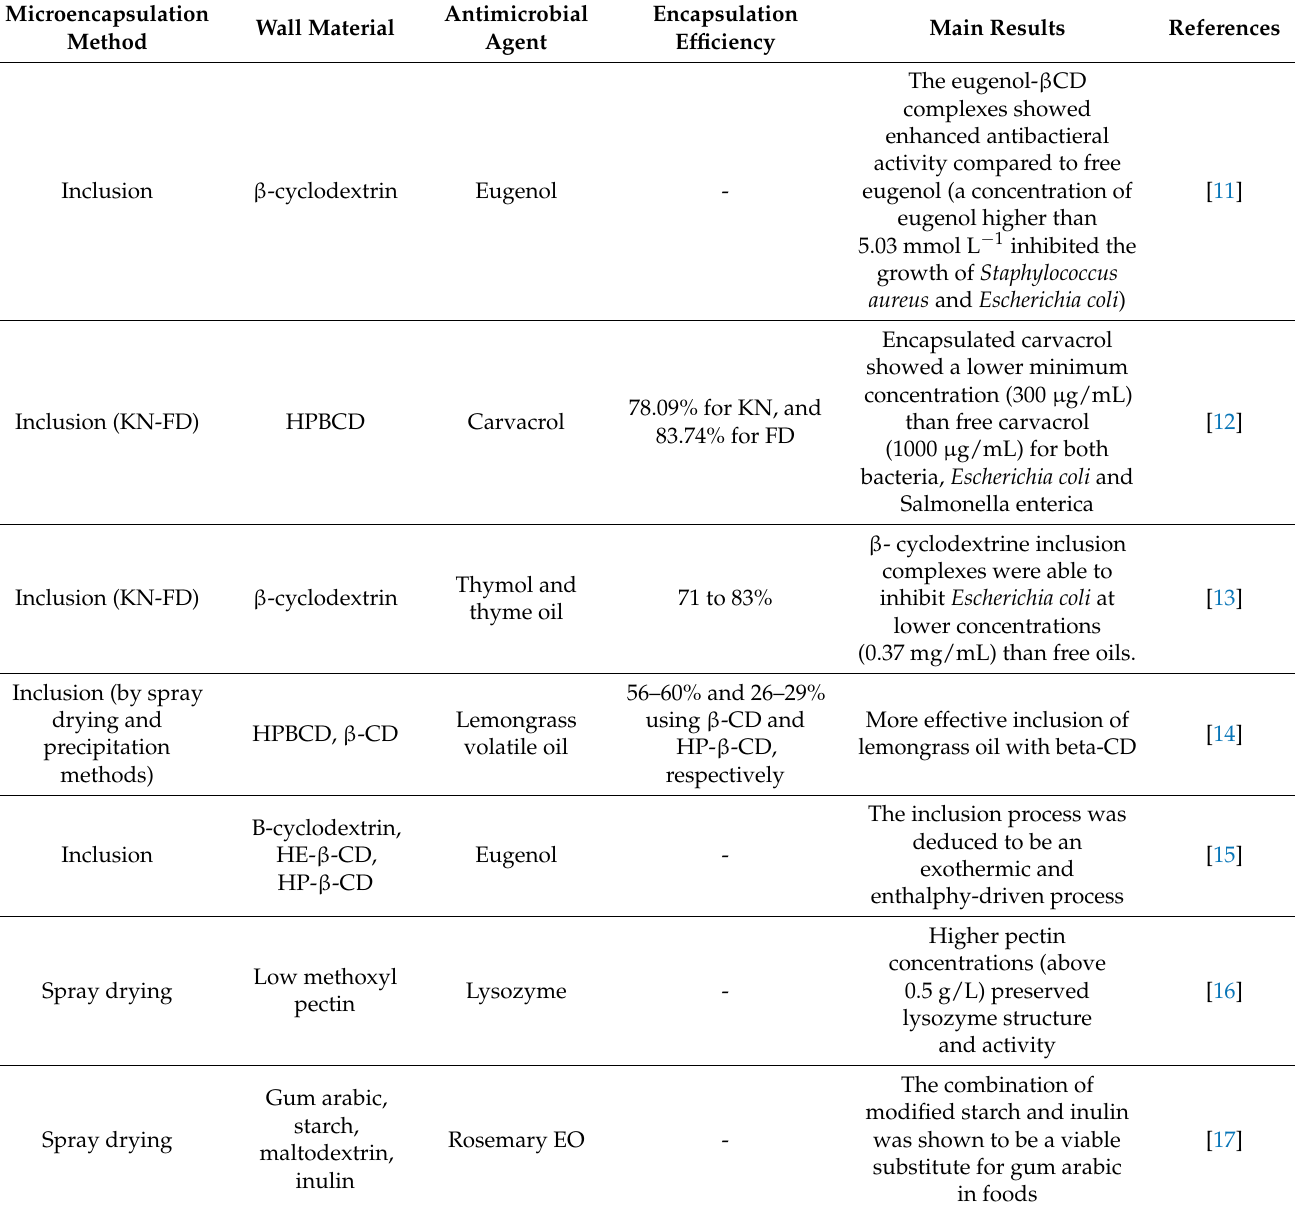
Table 1. Different methods, wall materials, encapsulation efficiency and main results for microencap- sulation of antimicrobial